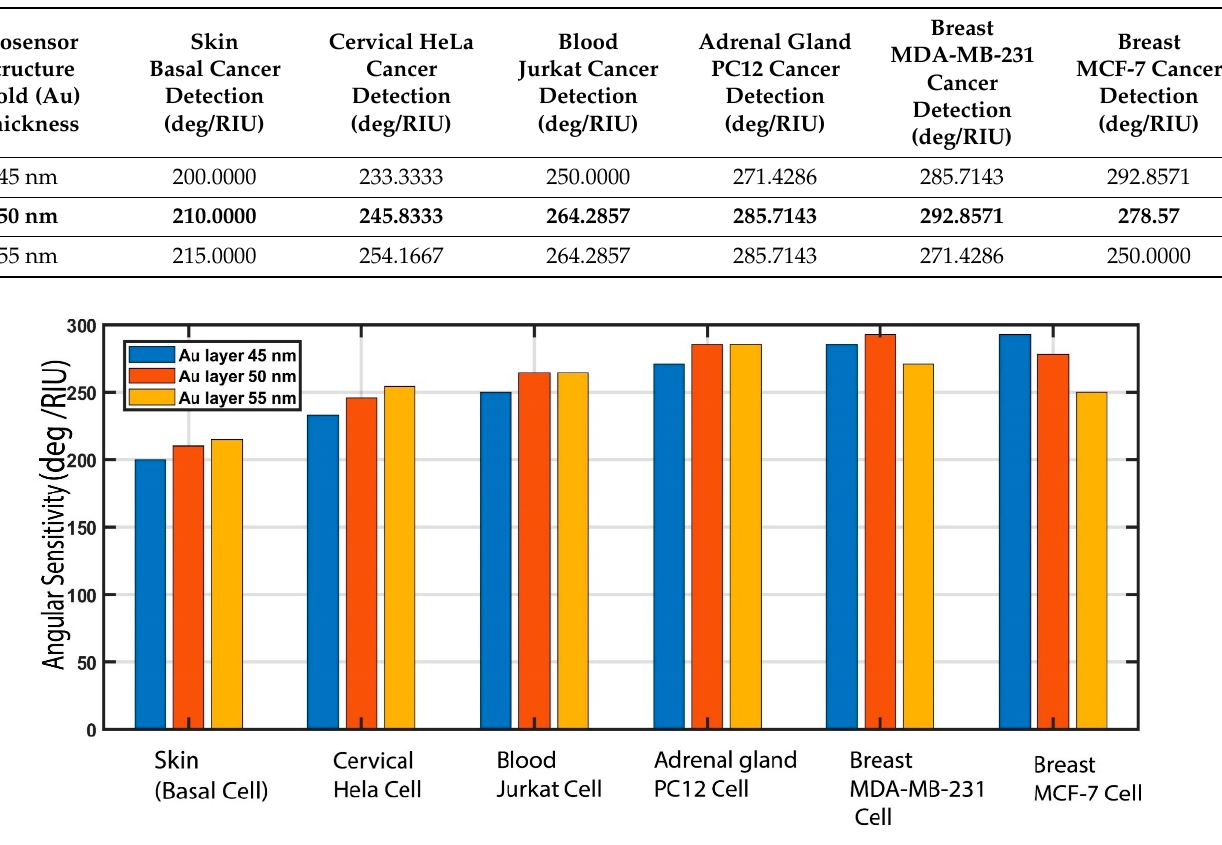
Figure 8. Analysis of the thickness of the gold (Au) layer for 45 nm, 50 nm, and 55 nm in the proposed BK 7 /TiO 2 /Au/graphene biosensor.